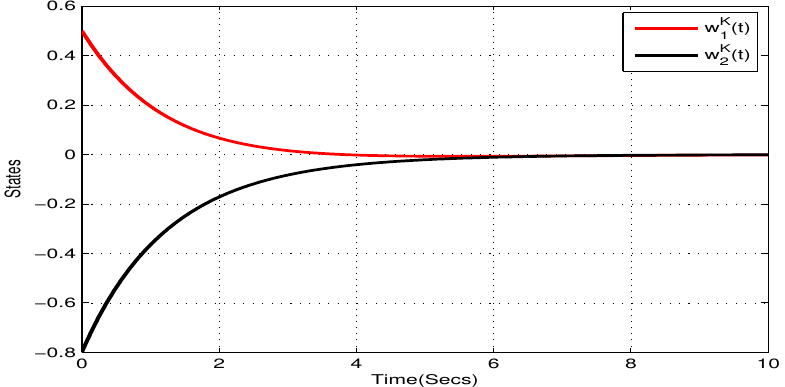
( t ) , w K ( t ) of systems (23) with state feedback control u 2 1